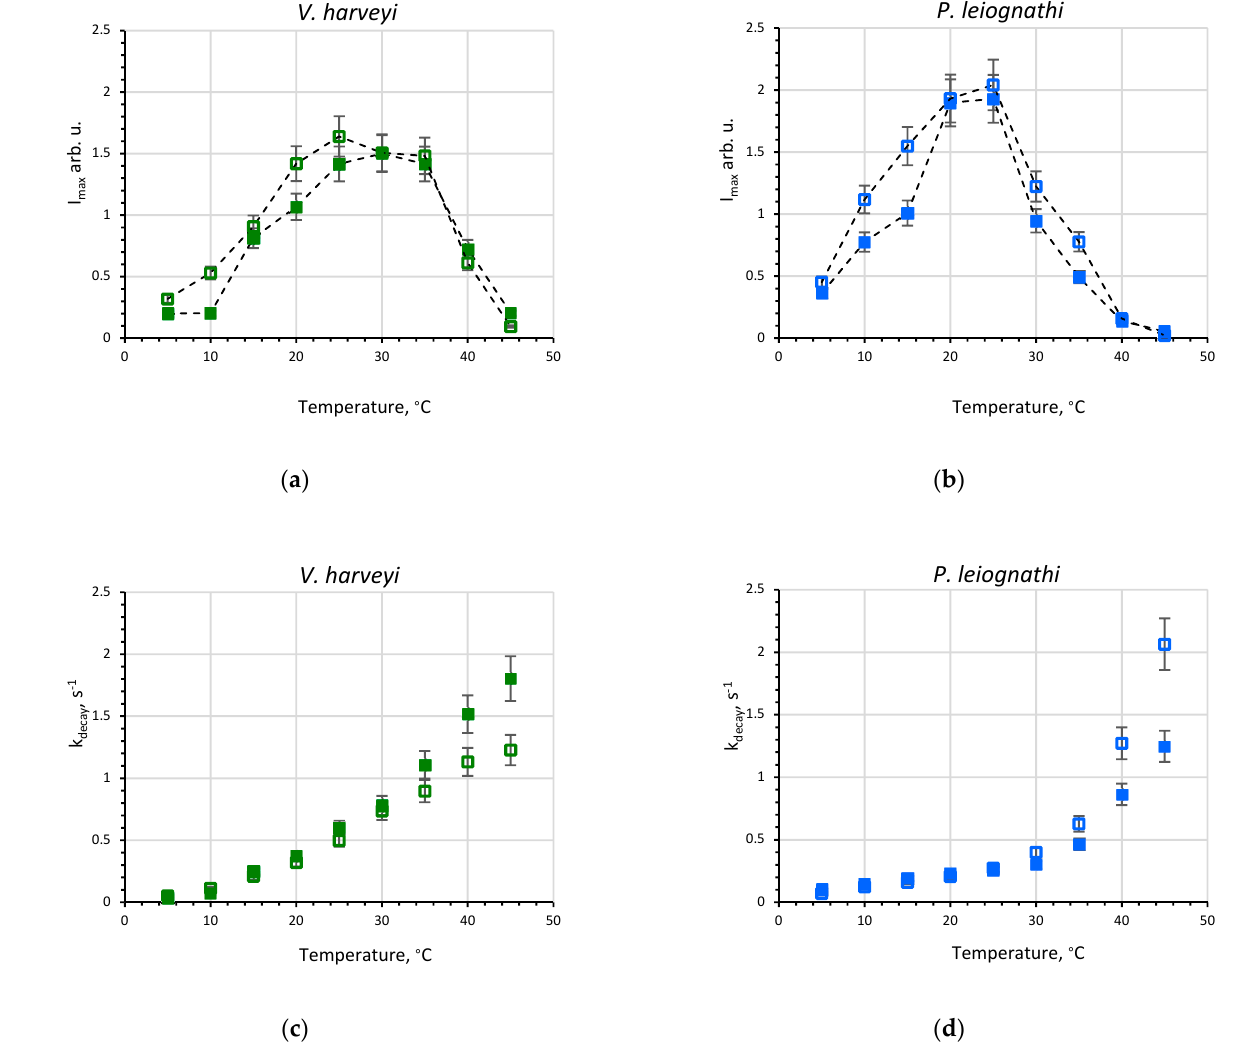
Figure 2. Dependence of kinetic parameters of luciferases from V. harveyi ( a , c ) and P. leiognathi ( b , d ) on temperature in the buffer (empty squares) and sucrose solution (filled squares): the peak intensity, I max , ( a , b ) and the decay constant, k decay , ( c , d ). The dashed lines are a guide for the eye. Concentrations in the reaction mixture were: luciferase—0.5 µM, flavin—15 µM, decanal—50 µM.